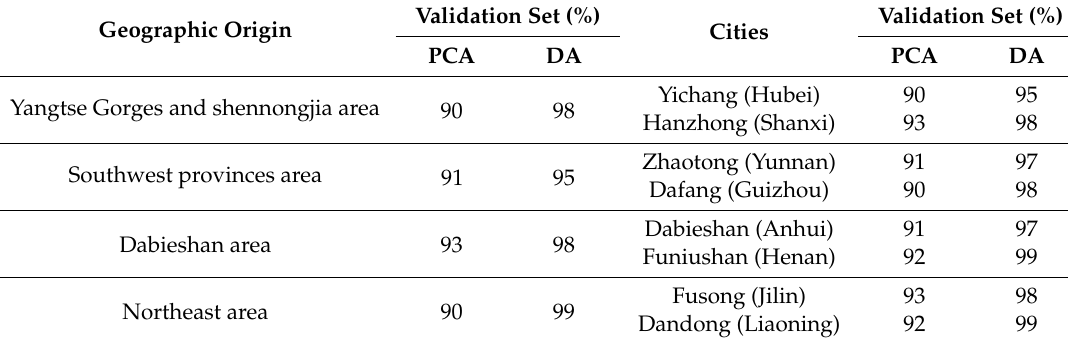
Table 6. Discrimination results (rate%) of established principal component analysis (PCA) and DA models for the G. elata validation